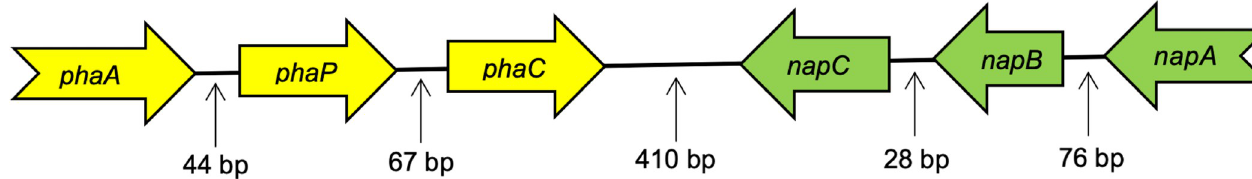
Fig 1. Map of the complete 5549-bp Bam HI fragment containing PHA synthesis genes from Vibrio B-18. The pha genes are involved in PHA synthesis: phaA encodes a PHA-specific 3-ketothiolase, phaP encodes a phasin, and phaC encodes PHA synthase. The napA-C genes encode proteins involved in the periplasmic reduction of nitrate. The large horizontal arrows indicate the orientation of the genes, while the small vertical arrows indicate the distance between the genes. The notched arrows indicate partial genes. This figure is not drawn to scale.